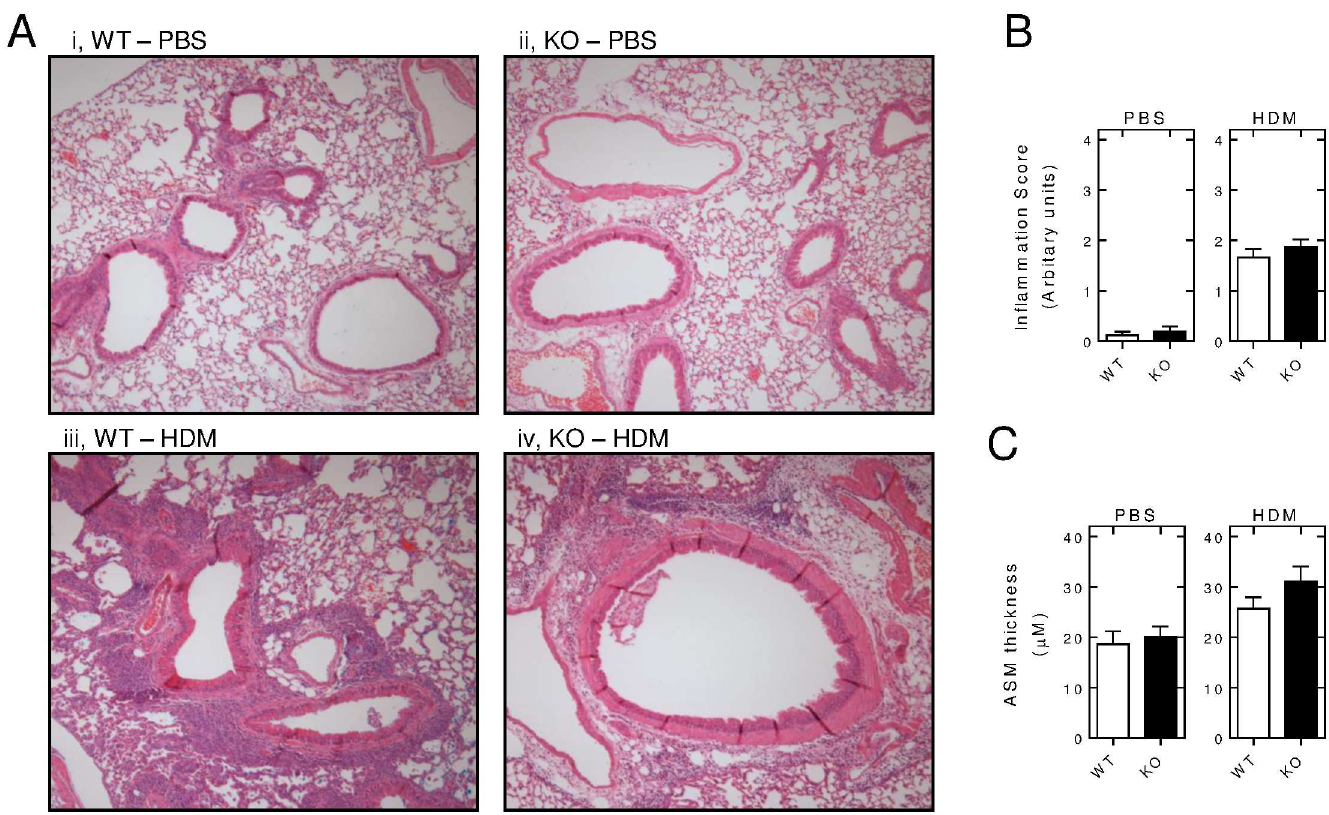
Fig 3. Effect of RGS2 deficiency on HDM-induced lung inflammation. Wild type (WT) and Rgs2 -/- (KO) mice were subjectedto i . n . instillation of PBS or HDM (25 μ g) 3 times/week for 3 weeks. Lungswere dissected, inflated and fixed in 10% formalin and embedded in wax. A, Sections were stainedwith H&E to allowvisualizationof inflammatory cell influx. B, Sections were scored using a semi-quantitative scoringsystem to evaluatethe fraction of the airway that was occupiedby inflammatory cell infiltrates: 4 = robust inflammation (more than 50% of airway circumference surroundedby inflammatory cell infiltrates); 3 = moderate inflammation (25–50%of airway circumference surrounded by inflammatory cell infiltrates); 2 = mild inflammation (10–25%of airway circumference surroundedby inflammatory cell infiltrates); 1 = minimalinflammation ( < 10%of airway circumference surrounded by inflammatory cell infiltrates) and a score of 0 = no inflammatory cell infiltrates. Numerical data were averaged from the 3 sectionstaken/animal. Data ( N = 17 PBS-exposed wild type and 15 Rgs2 -/- , N = 29 HDM-exposed wild type and 24 Rgs2 -/- ) are plotted as means ± SE. C, Image J software was used to measurethe cross- sectionalthickness of the ASM layer at 4 distinct regions surroundingthe airway lumen. Data ( N as in B) are plotted as means ±